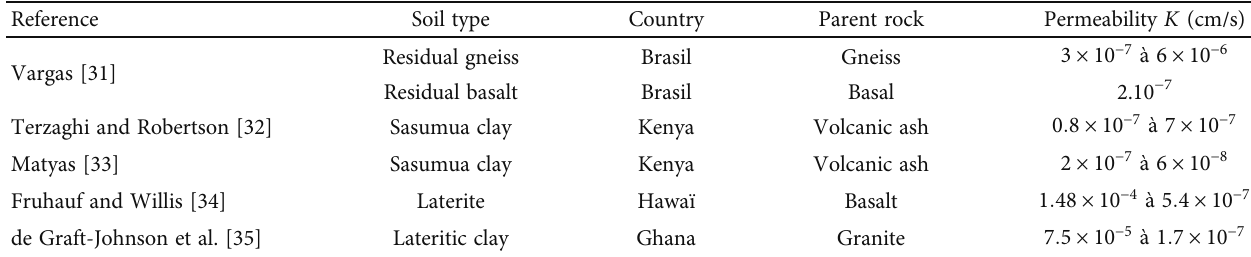
Table 2: Permeability of some residual tropical soils